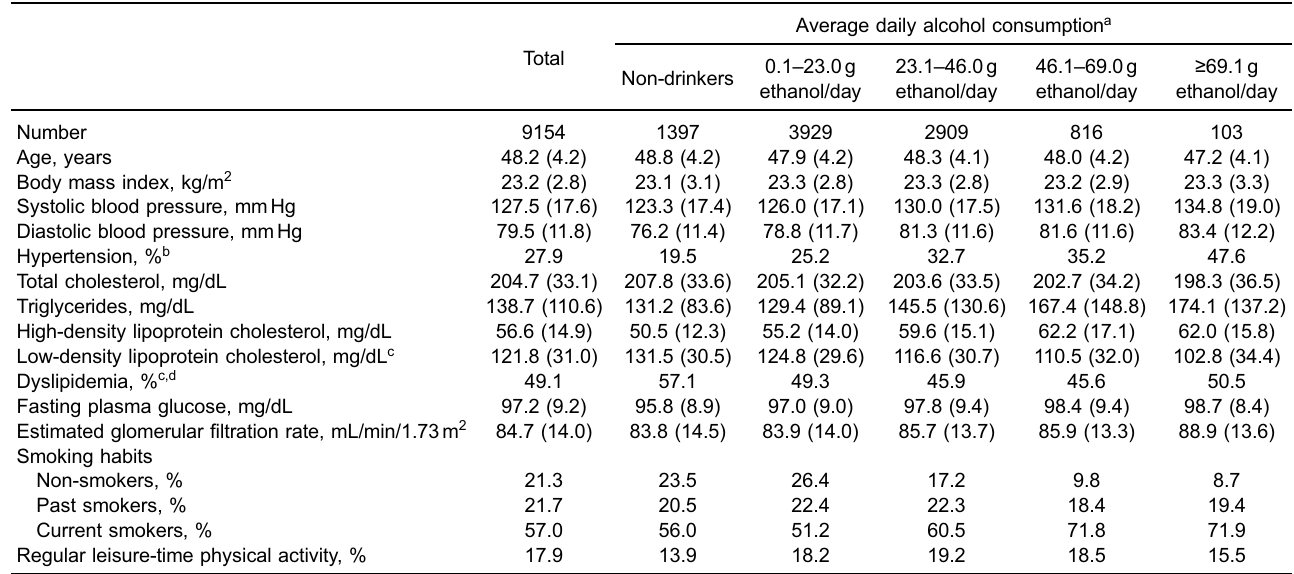
Table 1. Baseline characteristics of the subjects strati fi ed according to average daily alcohol